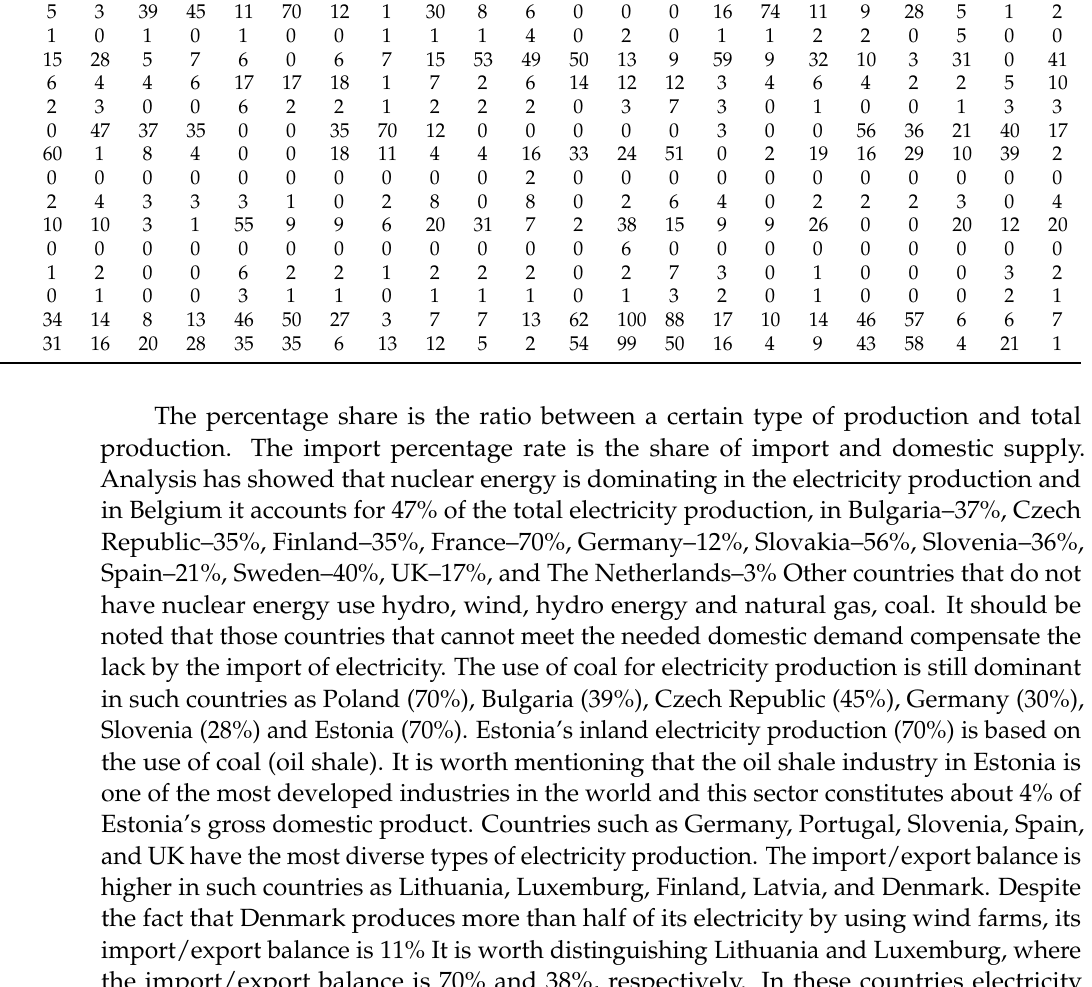
Table 2. Proportion of resources used in electricity generation (percentage rate in the year 2019) in EU countries.